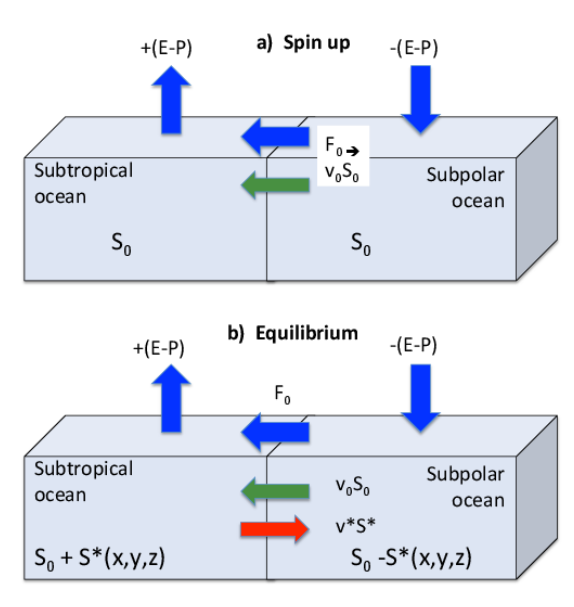
Fig. 2. Box model used to introduce the salt transport decomposi- tion. (a) schematic of the exchanges between the two boxes a short time into the spin-up (typically days or weeks). A barotropic flux F 0 is set up to carry the excess mass input into the subpolar box by precipitations, in order to avoid indefinite growth of the difference in sea level between the two boxes. It induces a barotropic transport of salt (noted as v 0 S 0 , green arrow); (b) schematic of the exchanges between the boxes at equilibrium. Salinity anomalies S ∗ develop as a consequence of the barotropic salt flux. Three-dimensional re- circulations are established over long timescales (years, decades) which carry salinity anomalies (the transport is noted v ∗ S ∗ , red ar- row). At equilibrium the salt content of each box is constant and the salt flux v ∗ S ∗ due to the recirculation cancels the salt flux v 0 S 0 carried by the barotropic volume flux F 0